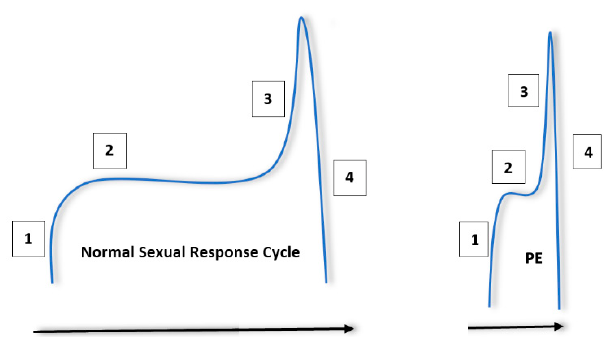
Figure 1. Normal sexual response cycle in men compared to men with premature ejaculation (PE). The steps are labelled in the order in which they occur. (1) Sexual arousal/excitement and penile tumescence. (2) Plateau period. (3) Increase in excitement/arousal to the point or ejaculation and orgasm. (4) Postejaculatory detumescence and resolution. It is important to note that patients with PE will experience a sharp excitement phase, followed by a short plateau and subsequent ejaculation.